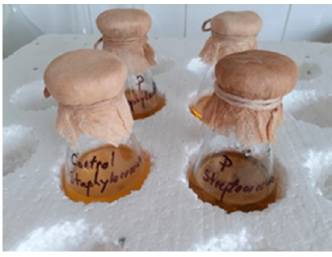
Figure 5. Incubated samples and controls.